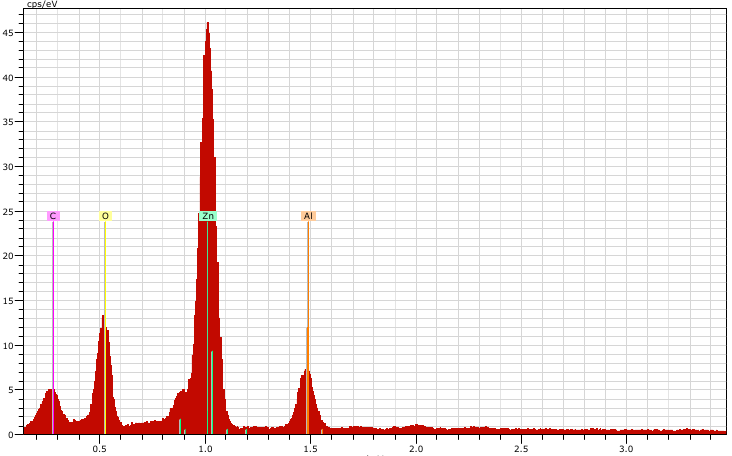
Figure 7. EDX spectrum of mycosynthesized ZnO NPs.